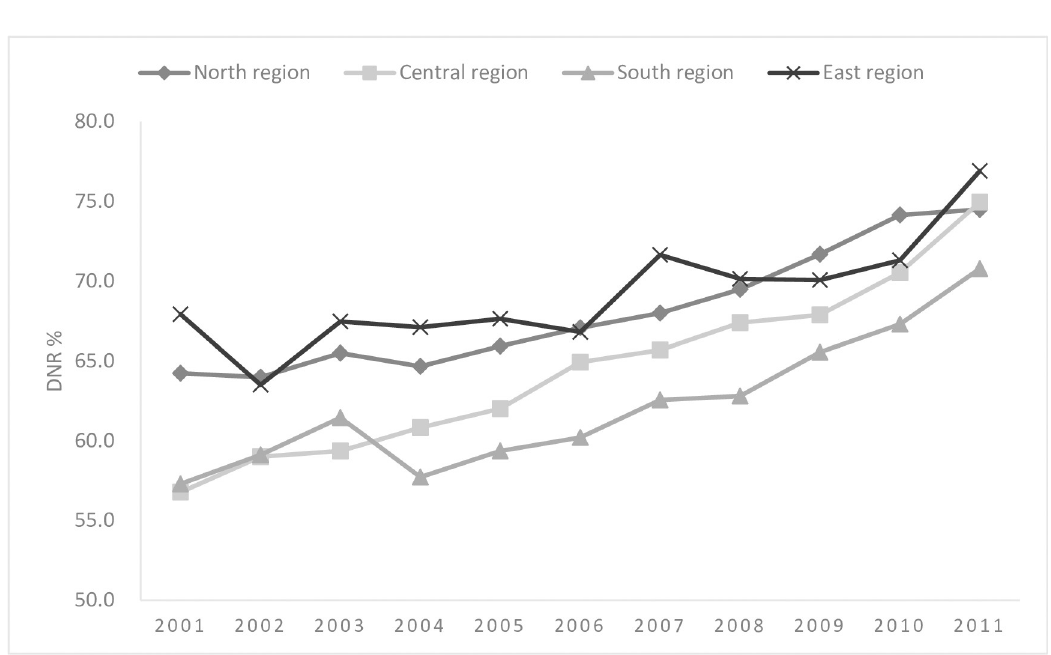
Fig 4. Geographic differences in do-not-resuscitate (DNR) rates in Taiwan.